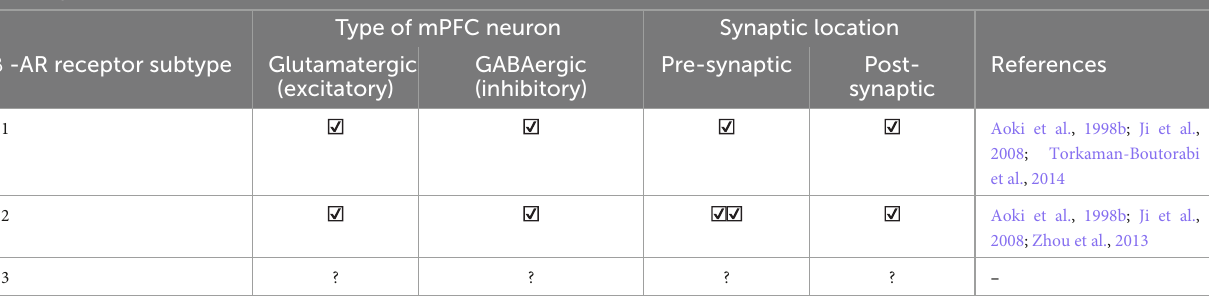
B) Presence of β -adrenergic receptor subtypes on excitatory and inhibitory neurons in the medial prefrontal cortex TABLE 2B